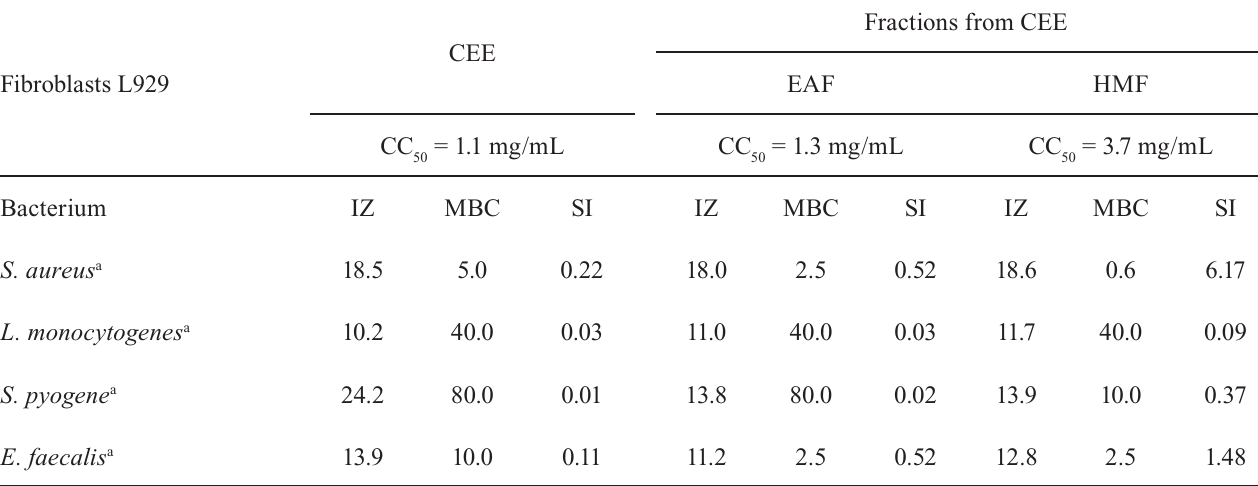
TABLE I - C ytotoxicity and antibacterial activity of ethanol extract (CEE) from leaves of P. spruceanum and its fractions